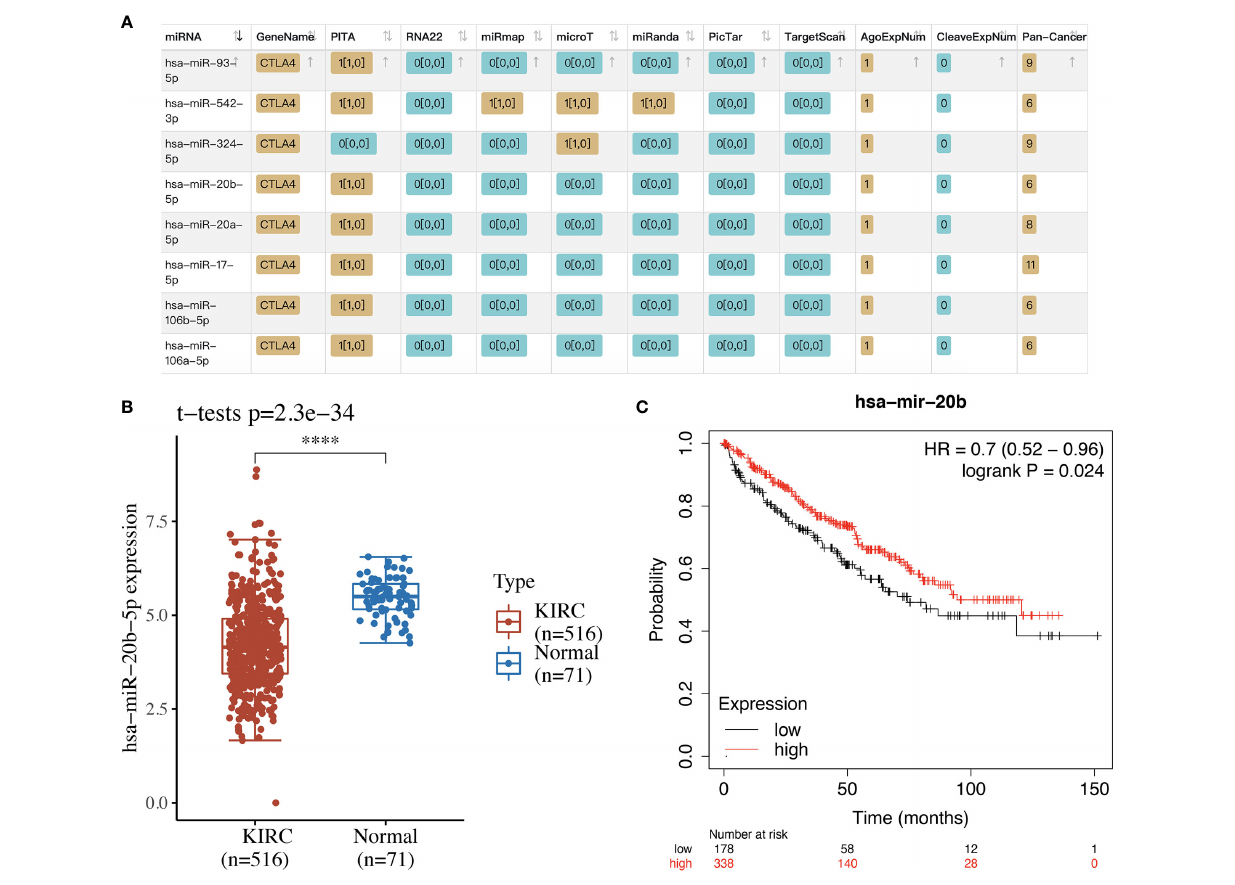
FIGURE 8 | The miRNA target of CTLA4 in KIRC. (A) The potential miRNA targets of CTLA4 in KIRC identi fi ed by starBase. (B) The expression of miR-20b-5p in KIRC tissues and normal renal tissues. (C) The overall survival curve of KIRC patients with high and low expression of miR-20b-5p. ****p <